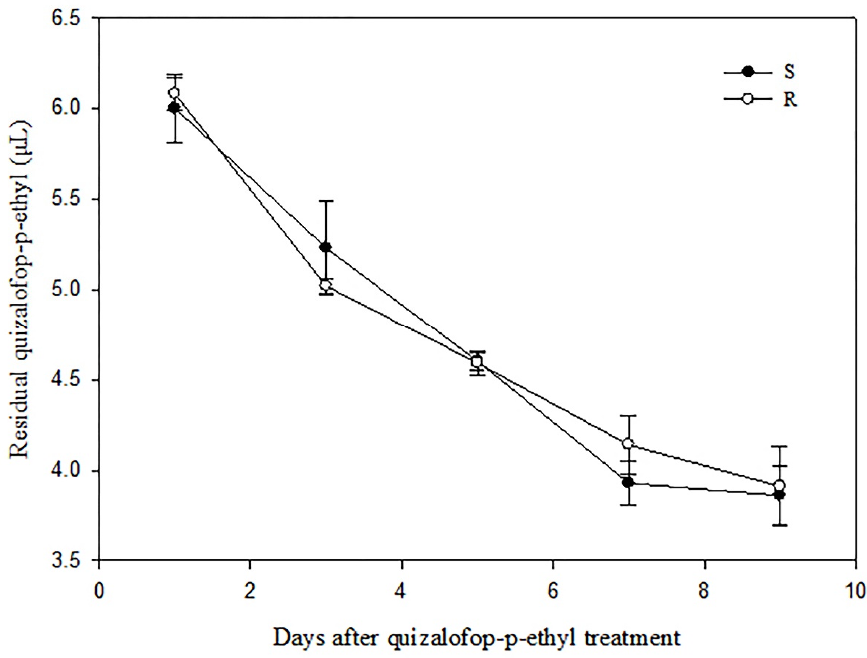
Figure 2. The quizalofop-p-ethyl residual in R and S Polypogon fugax populations 1, 3, 5, 7 and 9 days after quizalofop-p-ethyl treatment.